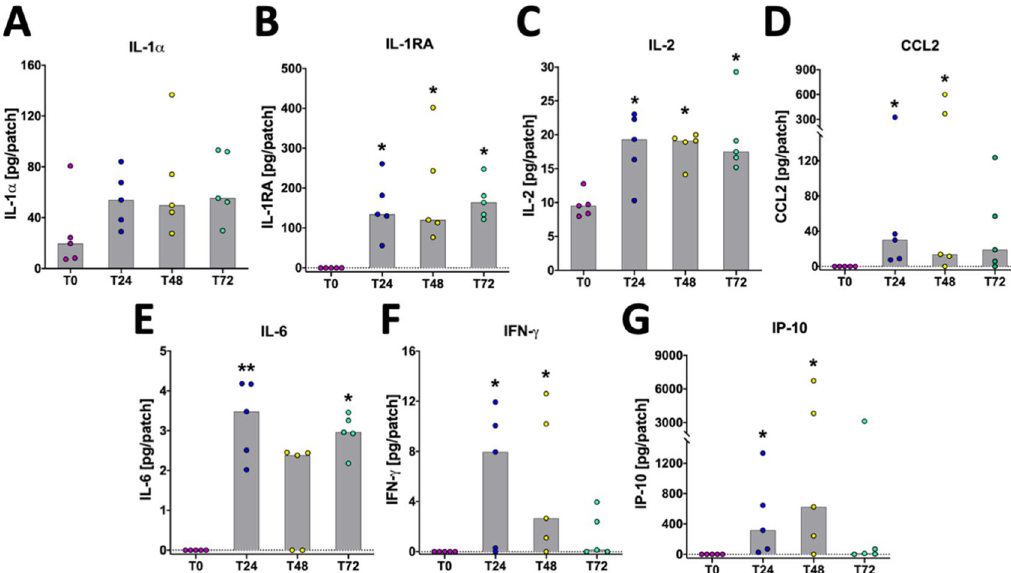
Figure 2. Kinetics of cytokine/chemokine profile in ISF collected from skin test sites of BCG vaccinated calves. ISF was collected prior to (T0) and 24, 48, and 72 h after injection of PPD-B (T24, T48, T72). Cytokine and chemokine content in ISF was determined using a bovine multiplex array via Luminex. Each dot represents the results of individual animal, with bars indicating median responses. Statistical analysis: Kruskal–Wallis with Dunn’s multiple comparison test relative to the T0 values: *, P < 0.05; **, P < 0.005.